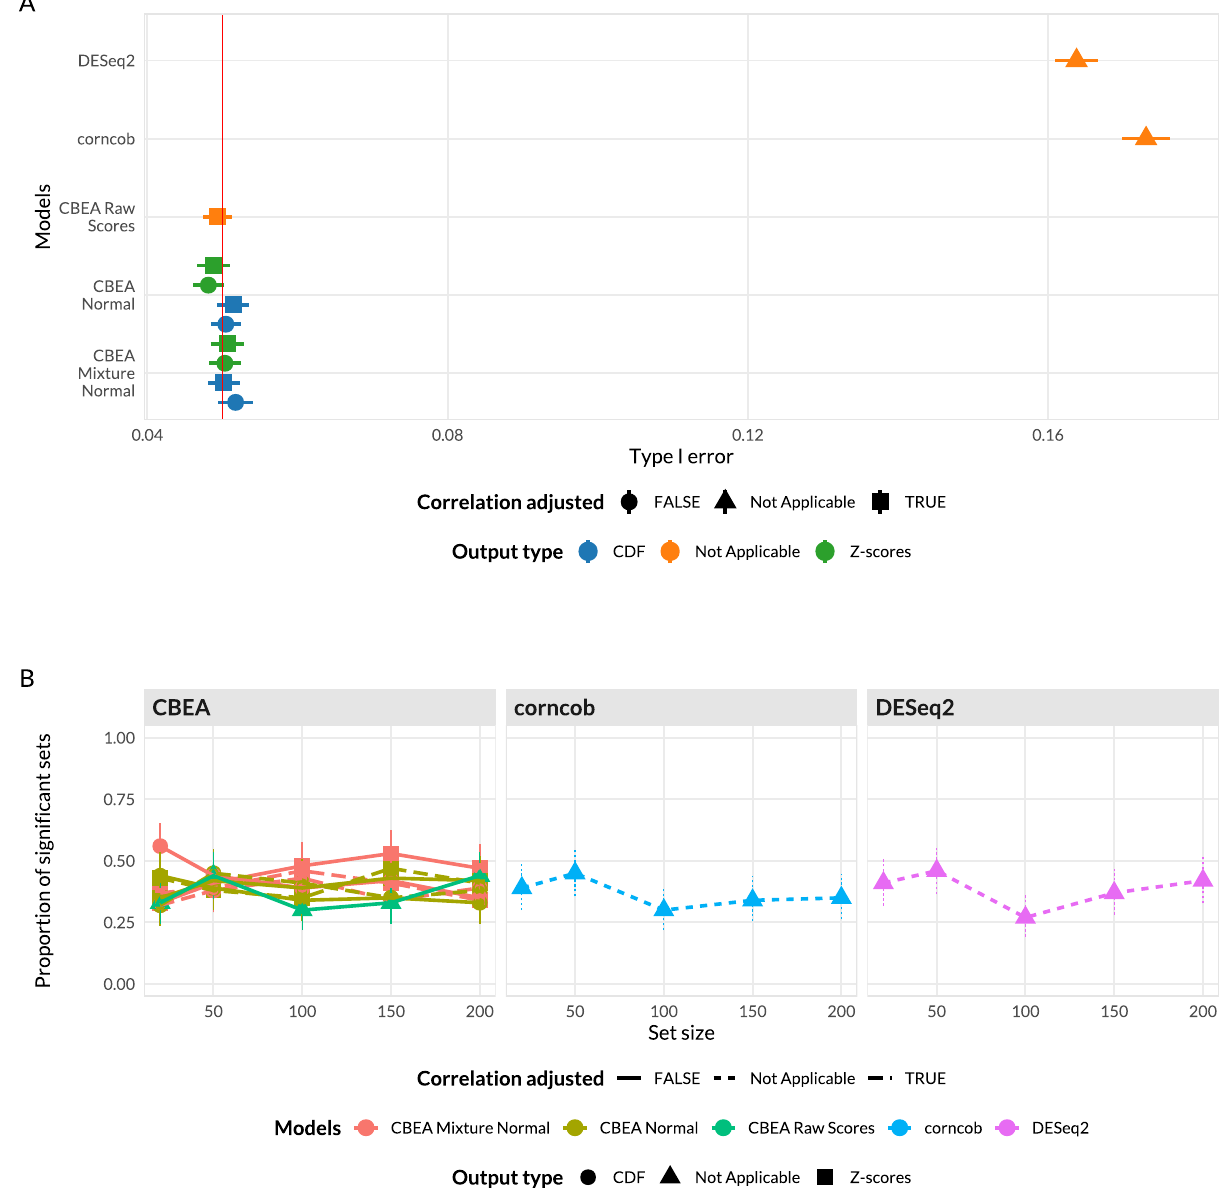
Fig 3. Random sample label (A) and random set (B) analyses for population level inference. ( A ) Type I error ( x -axis) was estimated as the overall fraction of sets found to be enriched α = 0.05 using randomly generated sample labels (500 permutations). Error bars represent the mean type I error ± sample standard error. ( B ) Proportion of significant sets ( y -axis) using 100 randomly generated sets of different set sizes ( x -axis). Confidence intervals computed using Agresti-Couli method for binomial proportions. For sample label permutation ( A ), all CBEA approaches were able to control for type I error but not for corncob and DESeq2. For random set analyses ( B ), all approaches demonstrated similar rates of accepting significant sets and were invariant to overall set